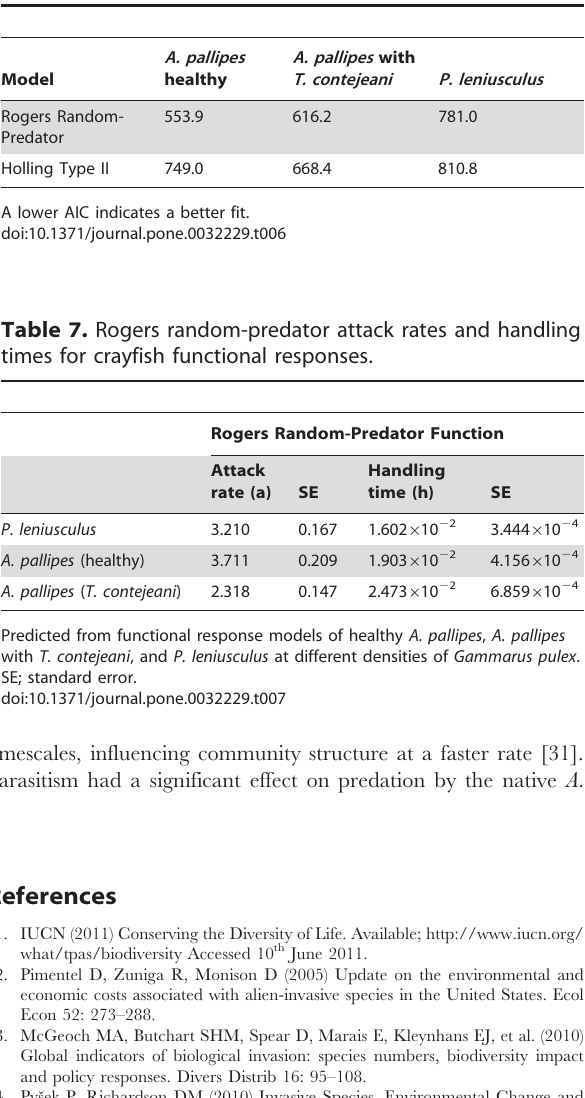
Table 6. Akaike Information Criterion (AIC) for two functional response models fitted for three crayfish groups.